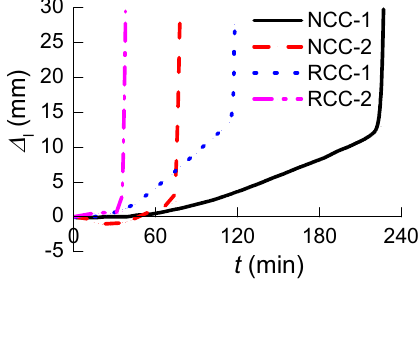
Figure 9. Specimen “vertical displacement to time” curves.